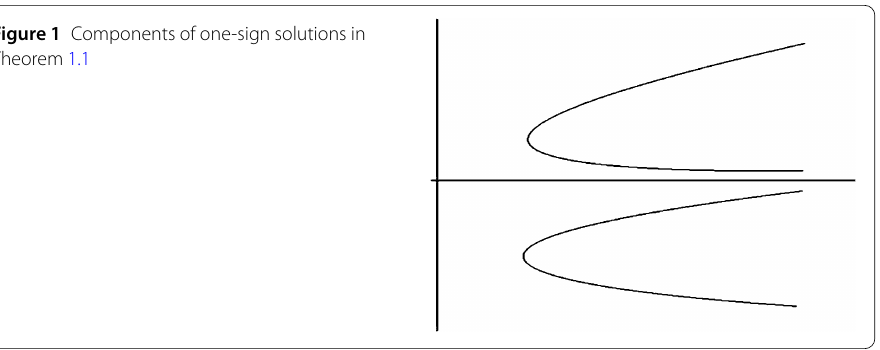
Figure 1 Components of one-sign solutions in Theorem